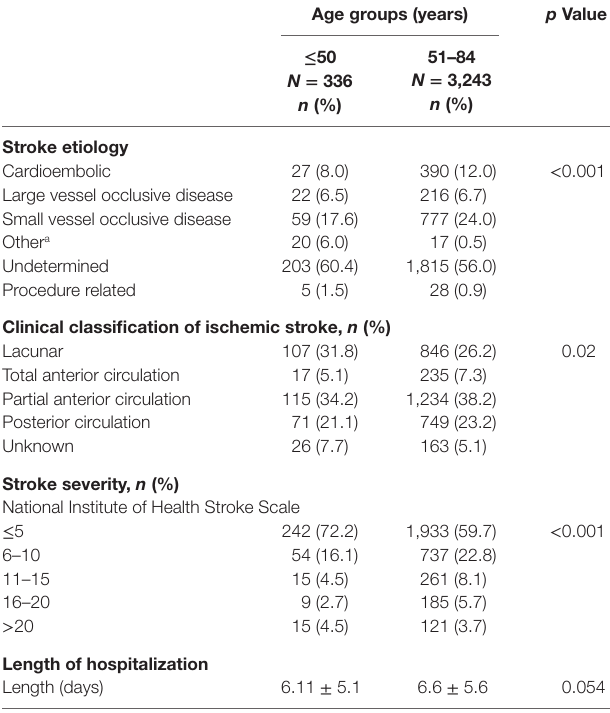
TaBle 2 | Stroke characteristics, severity at admission, by age